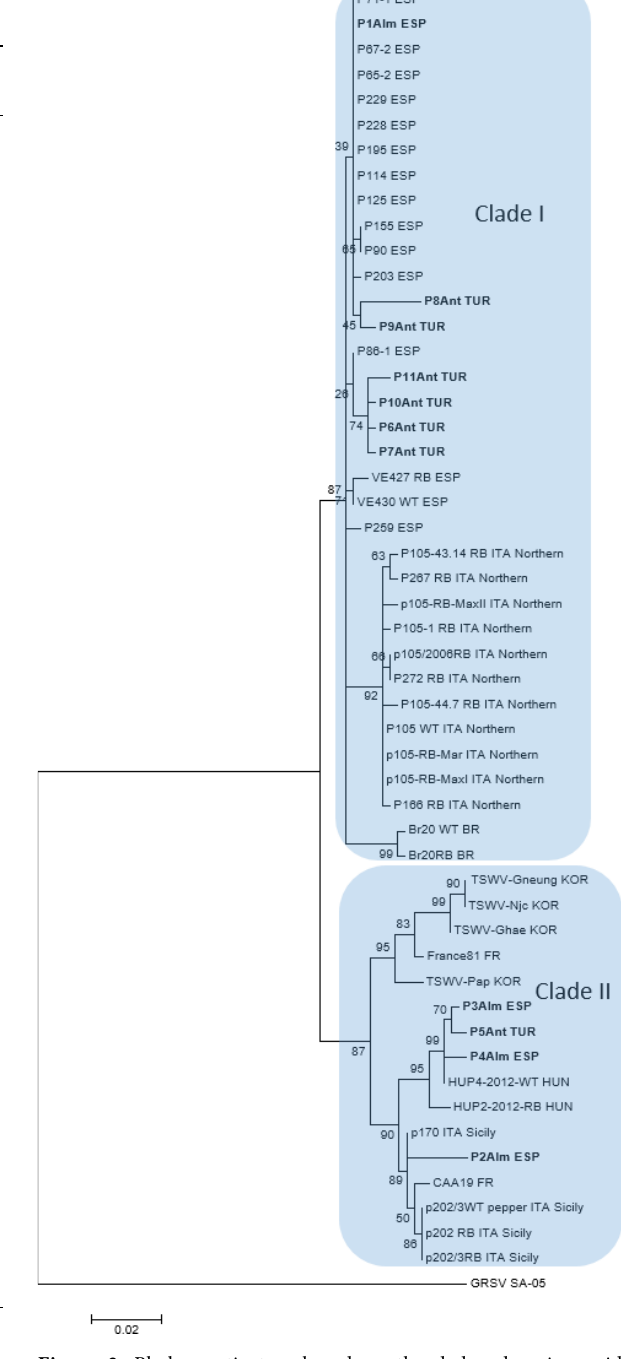
Figure 2. Phylogenetic tree based on the deduced amino acid sequences of the NSs protein of TSWV strains originated from pepper Maximum likelihood tree (1000 bootstrap replicates) was composed of TSWV strains retrieved from GenBank (see accession numbers in Table 2) and newly isolated strains in bold font (Table 1). Groundnut ringspot virus strain SA-05 (GenBank acc. number JN571117) was used as the outgroup. Two main clades (Clade I and Clade II) are